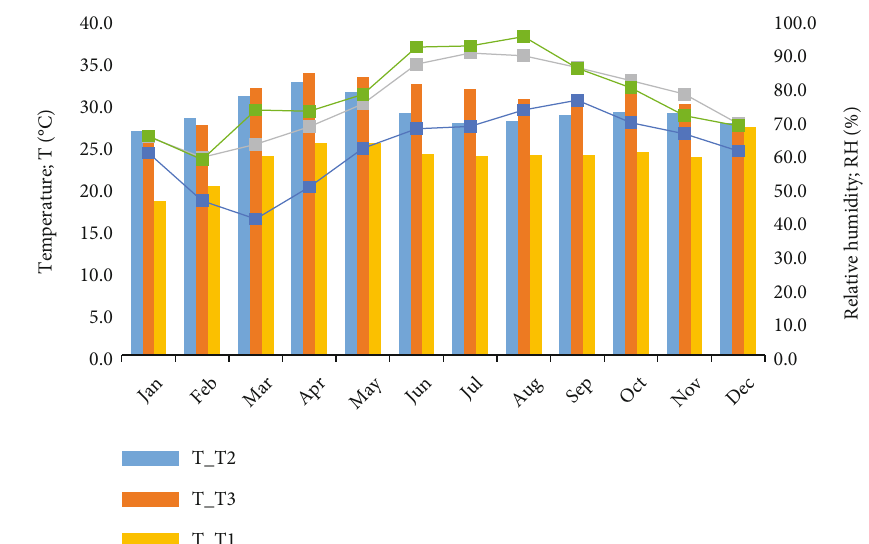
Figure 2: Temperature and relative humidity.